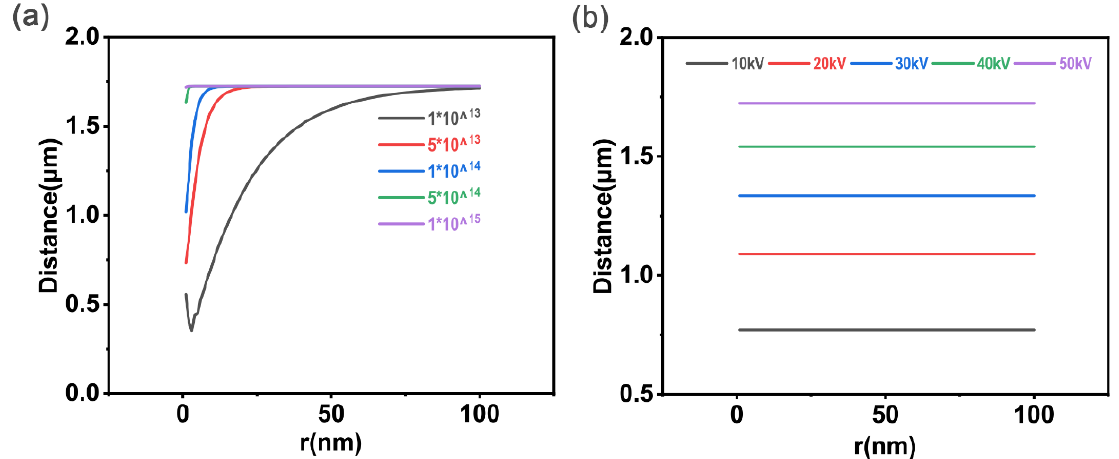
Figure 3. ( a ) U = 40 kV: the total penetration depth of the individual carbon black particle varies with carbon black particle size. ( b ) N = 1 × 10 17 ions/cm 2 : the total penetration depth of the individual carbon black particle varies with carbon black particle size.